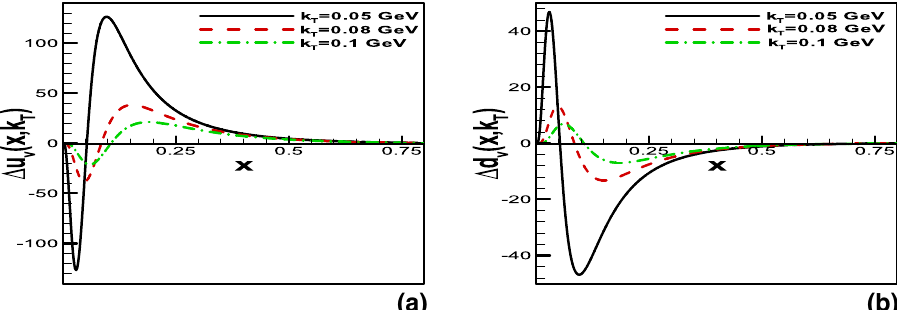
Fig. 7 The TMD polarized a up and b down valence quark distribution of proton with respect to x at three k T values = 1 GeV and Q 2 0